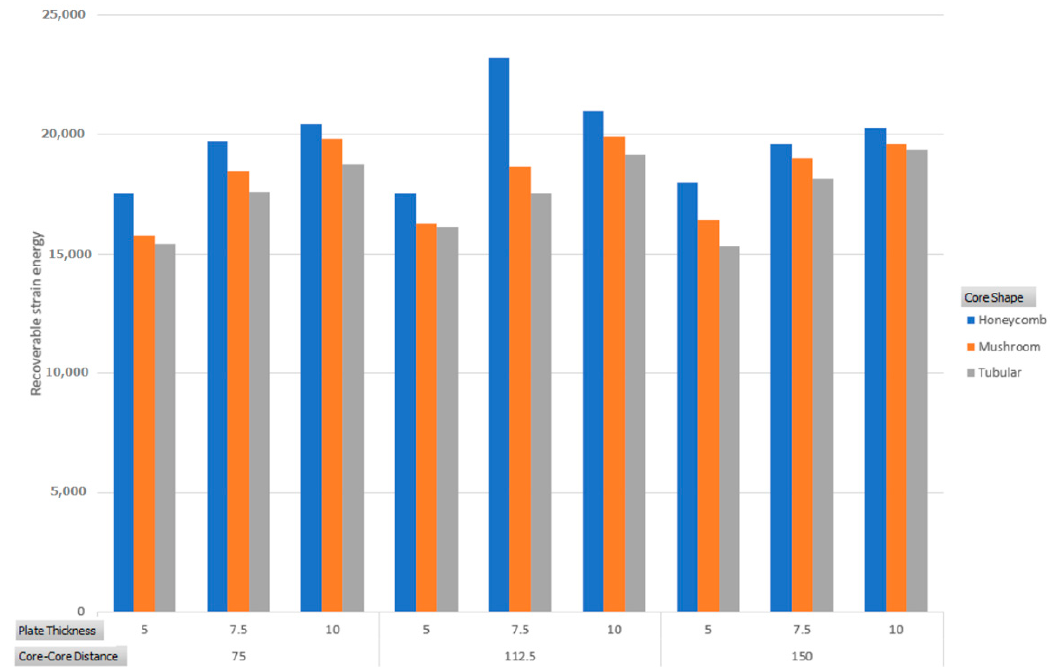
Figure 10. Elastic strain energy categorized by core shape, plate thickness, and core–core spacing.